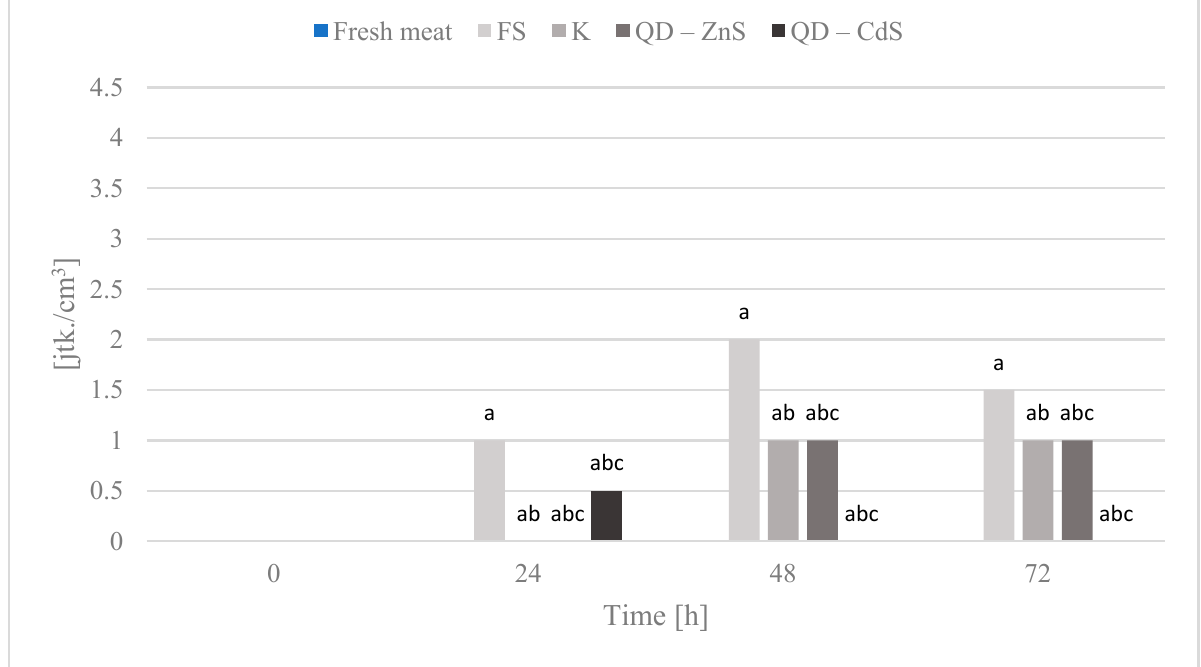
Figure 9. Campylobacter spp. Bacteria count in poultry meat stored under different films at about 4 °C. The parameters in the columns denoted with the same letters (a, b, c, etc.) do not differ statistically at the confidence level of p < 0.05.